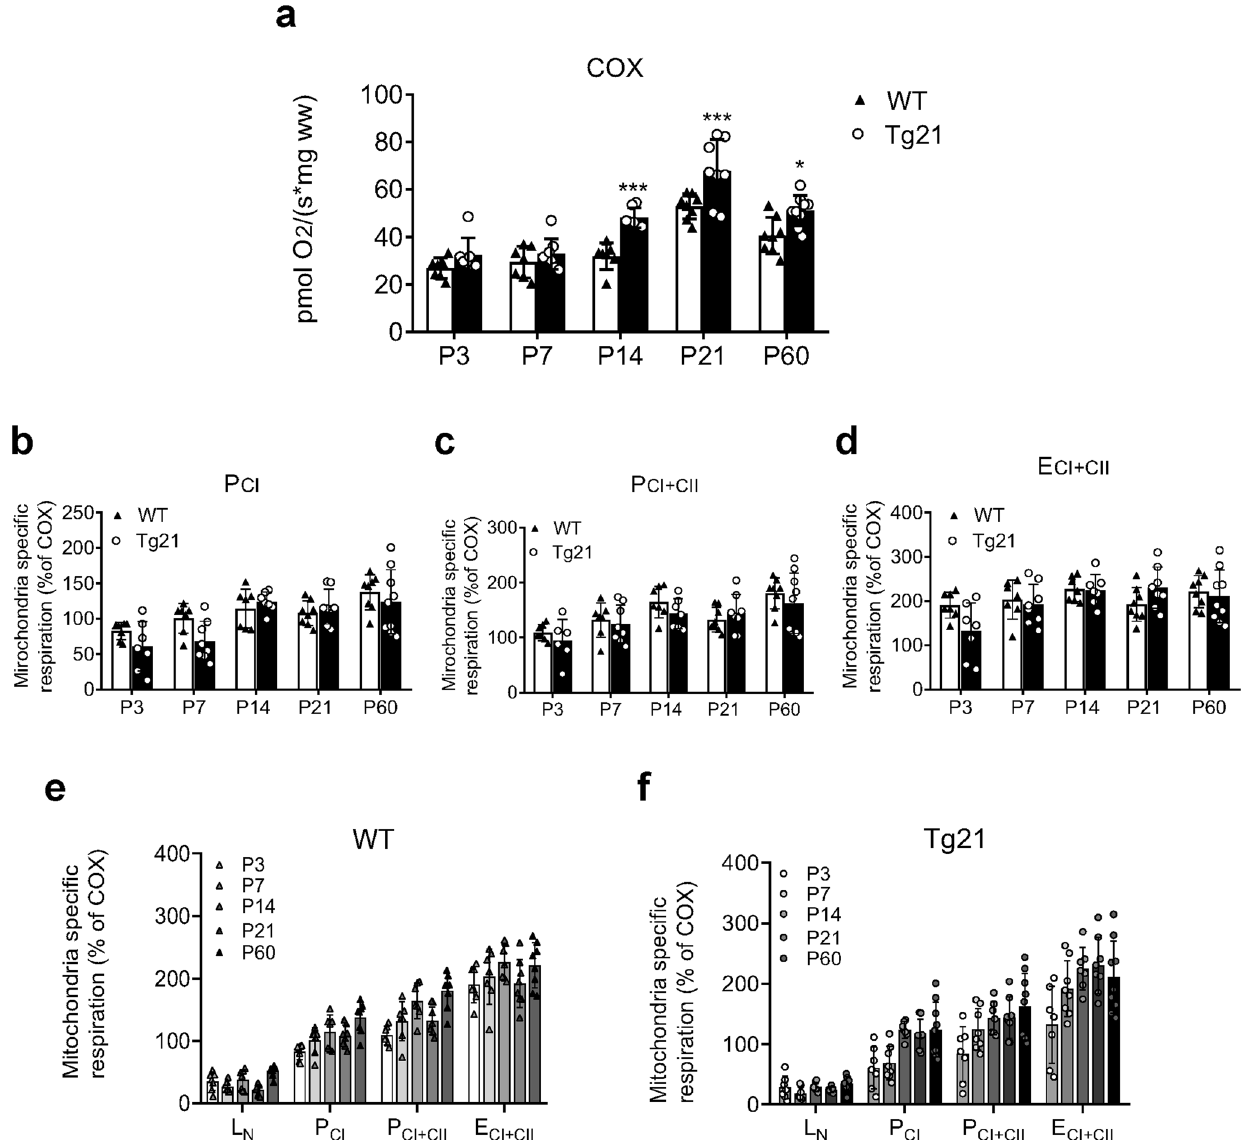
Fig. 3 EPO overexpression in the CNS in fl uences respiratory control by increasing mitochondria in the postnatal hippocampus. a Cytochrome C oxidase activity (COX, pmol O 2 /s * mg ww) in the hippocampus of WT and Tg21 throughout postnatal development. Tg21 mice show higher COX activity at P14, P21, and P60; 2-way ANOVA, F (1,66) = 36.77, **** p < 0.0001, with multiple comparisons: * p < 0.05, and *** p < 0.001. Mitochondria-speci fi c respiration for b P CI ; c P CI + CII ; and d E CI + CII throughout postnatal development in WT vs Tg21 mice. An increase in respiration throughout postnatal development is observed along with an increase in mitochondrial content in both genotypes for all respiratory states. No differences between genotypes are observed: (2- way ANOVA; P CI , F (1,66) = 2.40, p = 0.13); P CI + CII , F (1,66) = 2.28, p = 0.13; and E CI + CII , F (1,66) = 0.73, p = 0.40. Mass-speci fi c oxygen consumption rates (OCR) relative to COX (%) in e WT mice and f Tg21 mice for leak respiration without adenylates (L N ); complex I (P CI ); complex I and II (P CI + CII ); and maximal non-coupled respiration with electron input from complex I and II (E CI + CII ) at postnatal ages of P: 3, 7, 14, 21, and 60. Mass-speci fi c respiratory differences between genotypes are lost when normalizing to COX, a surrogate of mitochondrial content; 1-way ANOVA: WT, F (4,15) = 0.24, p = 0.91; and Tg21, F (4,15) = 0.45, p = 0.76. Barplots with SD way ANOVA, F (1,22) = 28.18, p < 0.001; Fig. 7a upper left panel). a possible increase in synaptic transmission in fl uencing hippo- The swimming path length was not different between genotypes campal function in Tg21 mice. during the acquisition phase (2-way ANOVA, F (1,22) = 0.85, p = 0.36; Fig. 7a, upper middle panel). However, EPO overexpression in CNS enhances hippocampal-dependent the indication of enhanced learning in Tg21 compared to WT spatial navigation and short-term memory controls was evident across days with Tg21 mice showing longer Morris water maze (MWM) test . Young adult mice from both swim paths on d1, negligible differences in swim paths on d2, and genotypes successfully learned to fi nd the hidden platform during shorter swim paths on d3 and d4. Additionally, Tg21 mice the acquisition phase, as demonstrated by the escape latency and exhibited faster swim speeds than WT controls across all days (2- swimming path length (Fig. 7a, upper panels). A shorter escape way ANOVA, F (1,22) = 62.4, p < 0.0001; Fig. 7a upper right latency was observed in Tg21 mice beginning on day 2 (d2) (2-